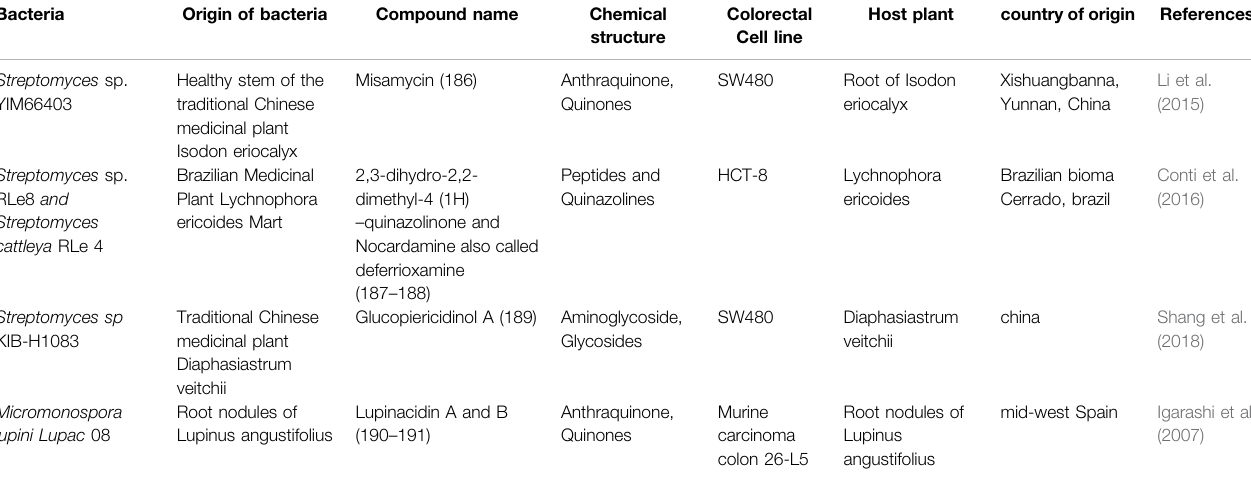
TABLE 2 | the structure of some NPs with anti-CRC properties from the endophytic actinobacteria and their mechanism of action and